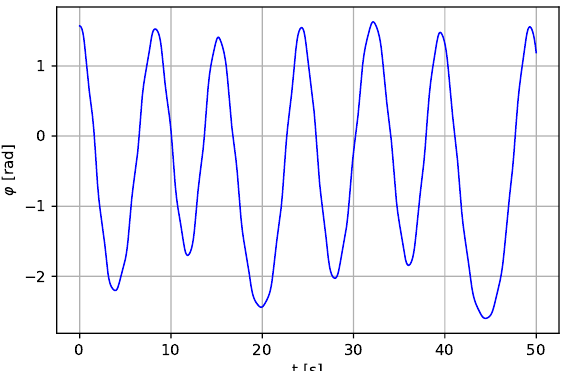
Figure 18. Angular displacement ϕ ( t ) of the pendulum (Case II—a variable length concept of the pendulum pump) for c p = 0.1 N